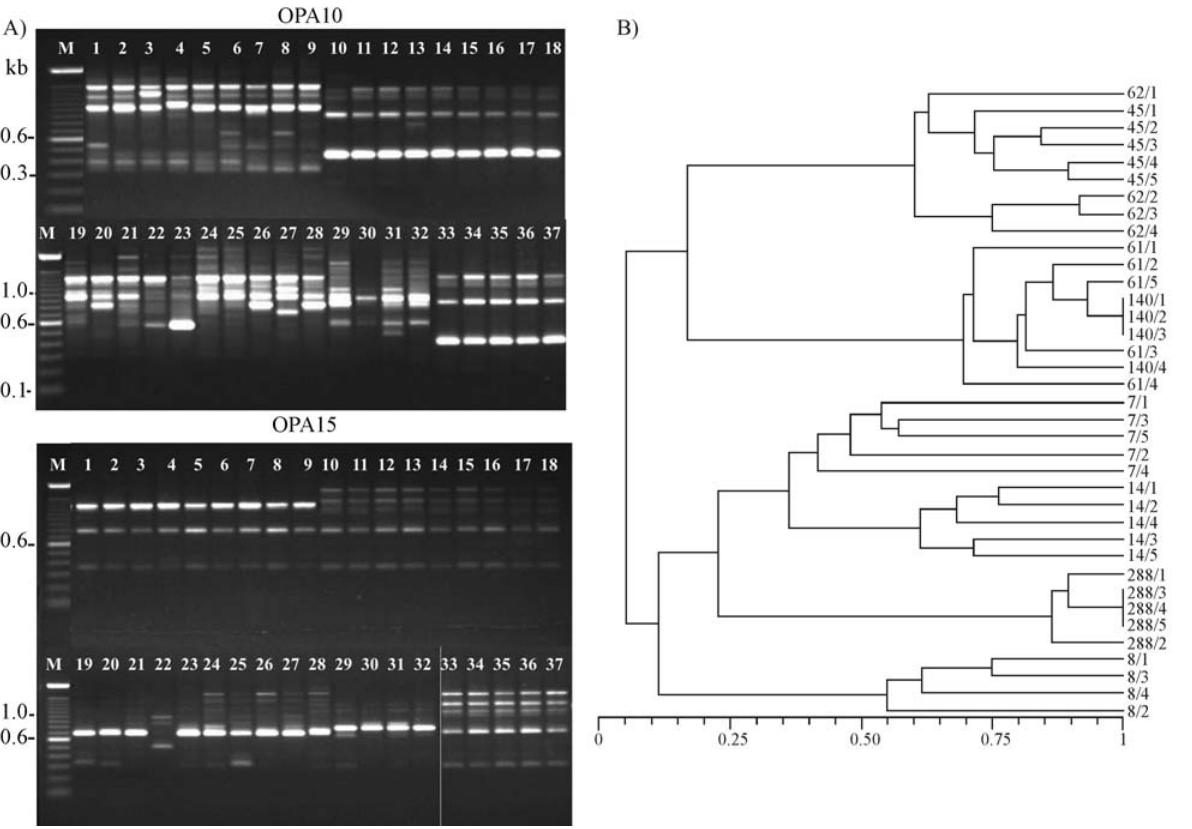
Figure 1 - A) RAPD amplicons produced by the OPA10 and OPA15 primers with DNA from different Bemisia tabaci biotypes. Numbers are: 1-4, A biotype (USA); 5-9, BR biotype (Brazil); 10-14, B biotype collected from melon (USA); 15-18, B biotype from soybean (Brazil); 19-23, Q biotype (Mo- rocco); 24-28, Q biotype (Spain); 29-32, Cassava biotype (Nigeria); 33-37, B biotype collected from tomato (Brazil). M, ladder 100 bp. B) Dendrogram showing the similarity among the populations of the B. tabaci complex biotypes, constructed with RAPD data and obtained by a Jaccard’s coefficient us- ing UPGMA and